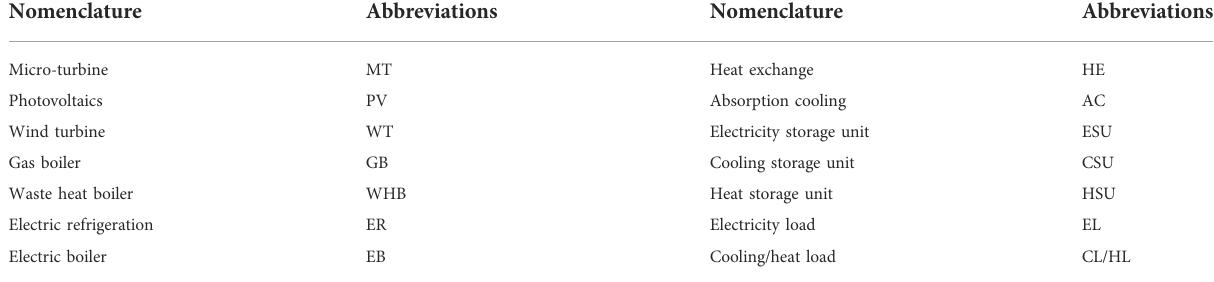
TABLE 1 Symbol de fi nition of equipment in